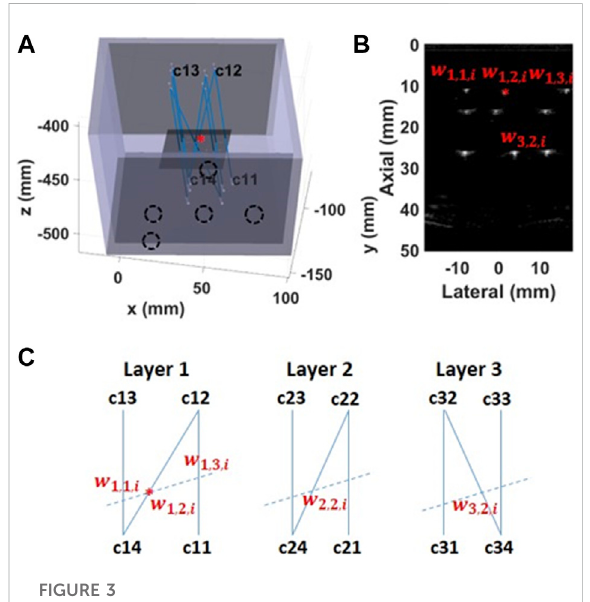
FIGURE 3 Spatial calibration using an “ N ” -wire phantom (A) The calibrationphantomisa3Dprintedboxwithpre-de fi nedpositions for the optical markers (black dashed circles) and sealed holes for wires (B) An US image has visible wires ’ cross-sections. The middle wire was used for the calibration (red star) (C) The schematic of each wires ’ layer viewed from the top of the phantom. The dashed line represents crossing of the US image with the wires ’ layer.